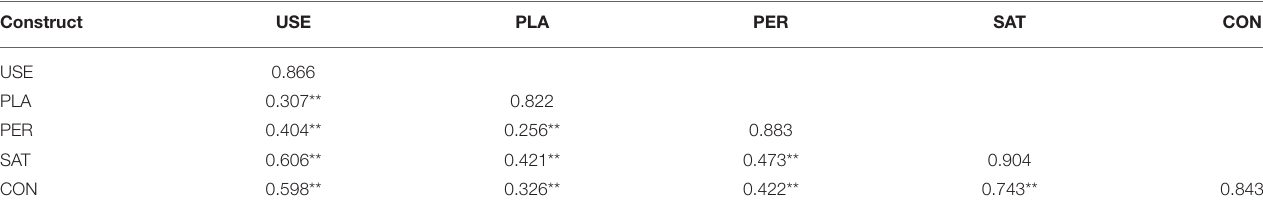
TABLE 2 | Correlation coefficient matrix and square roots of AVE.